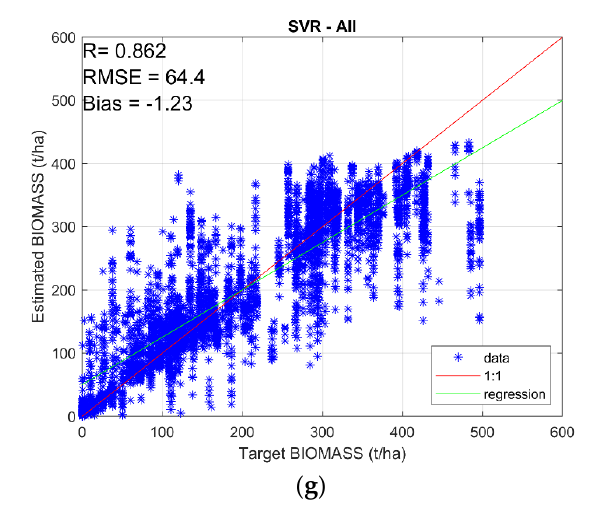
Figure 6. True vs. estimated biomass using SVR: ( a ) AfriSAR DLR, ( b ) AfriSAR Onera, ( c ) BioSAR 1, ( d ) BioSAR 2, ( e ) BioSAR 3, ( f ) TropiSAR, and ( g ) All (general algorithm).